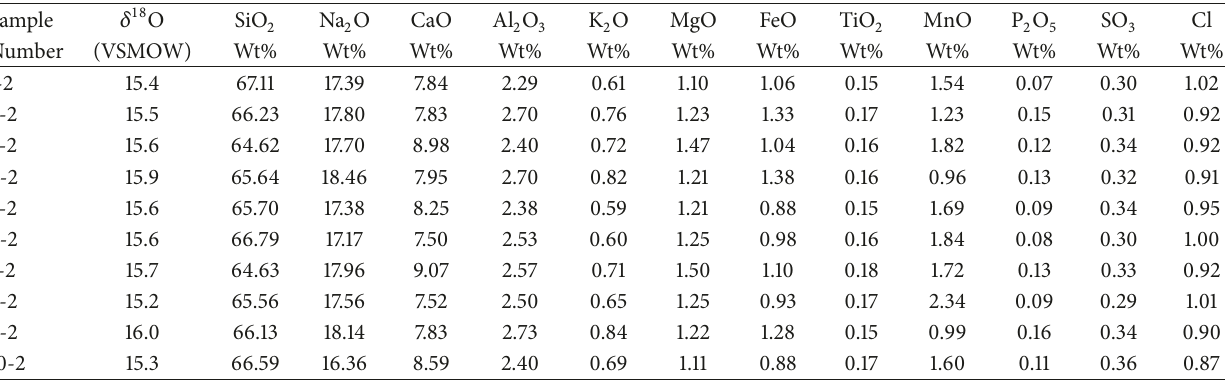
Table 3: Isotopic and chemical composition of glasses from Maroneia, 4th–6th centuries AD in age. Note that CoO, NiO, CuO, ZnO, SnO 2 , Sb 2 O 3 , and PbO contents are not reported because they are lower than EMPA detection limits for all samples (LOD of CoO, NiO and CuO =